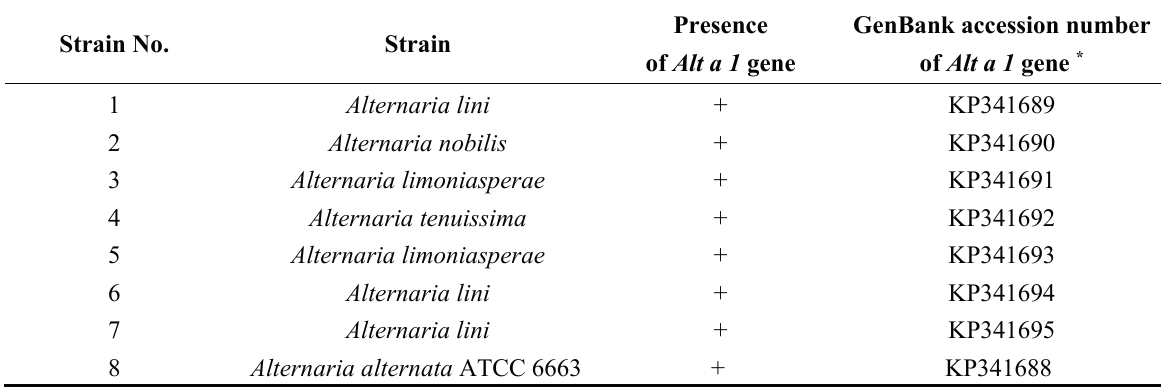
Table 5. Detection of Alt a 1 gene for tested Alternaria